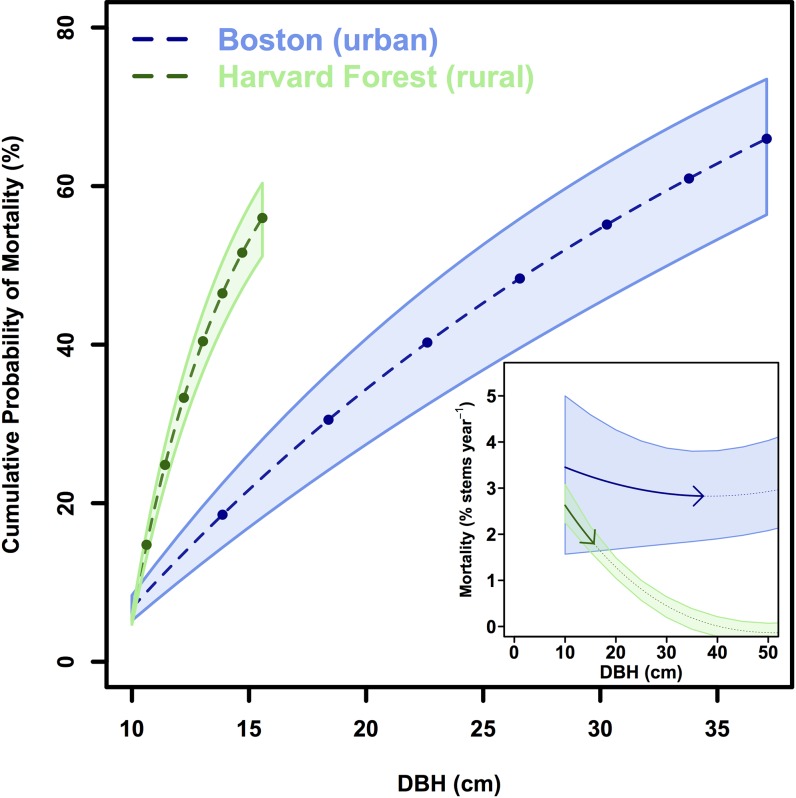
Mortality probability.Cumulative probability of mortality (%) vs. DBH (cm) for a 10 cm DBH tree in an urban vs. rural environment over a 35 year period. Points represent 5 year increments. Inset: Annual mortality rates (%) vs. DBH (cm) in Boston and at the Harvard Forest. Solid arrows represent the trajectory of the 10 cm DBH tree after 35 years.